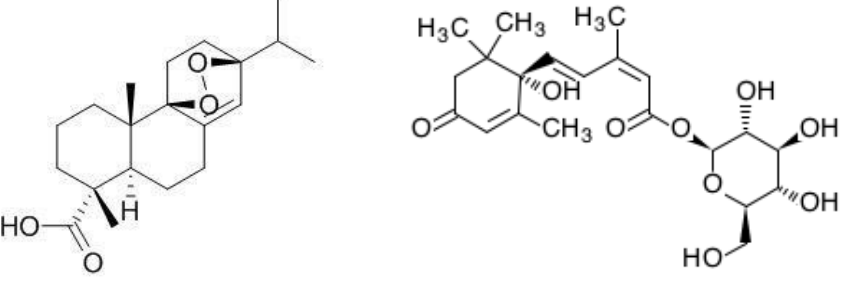
Figure 10. Allelochemicals of Pinus densiflora .